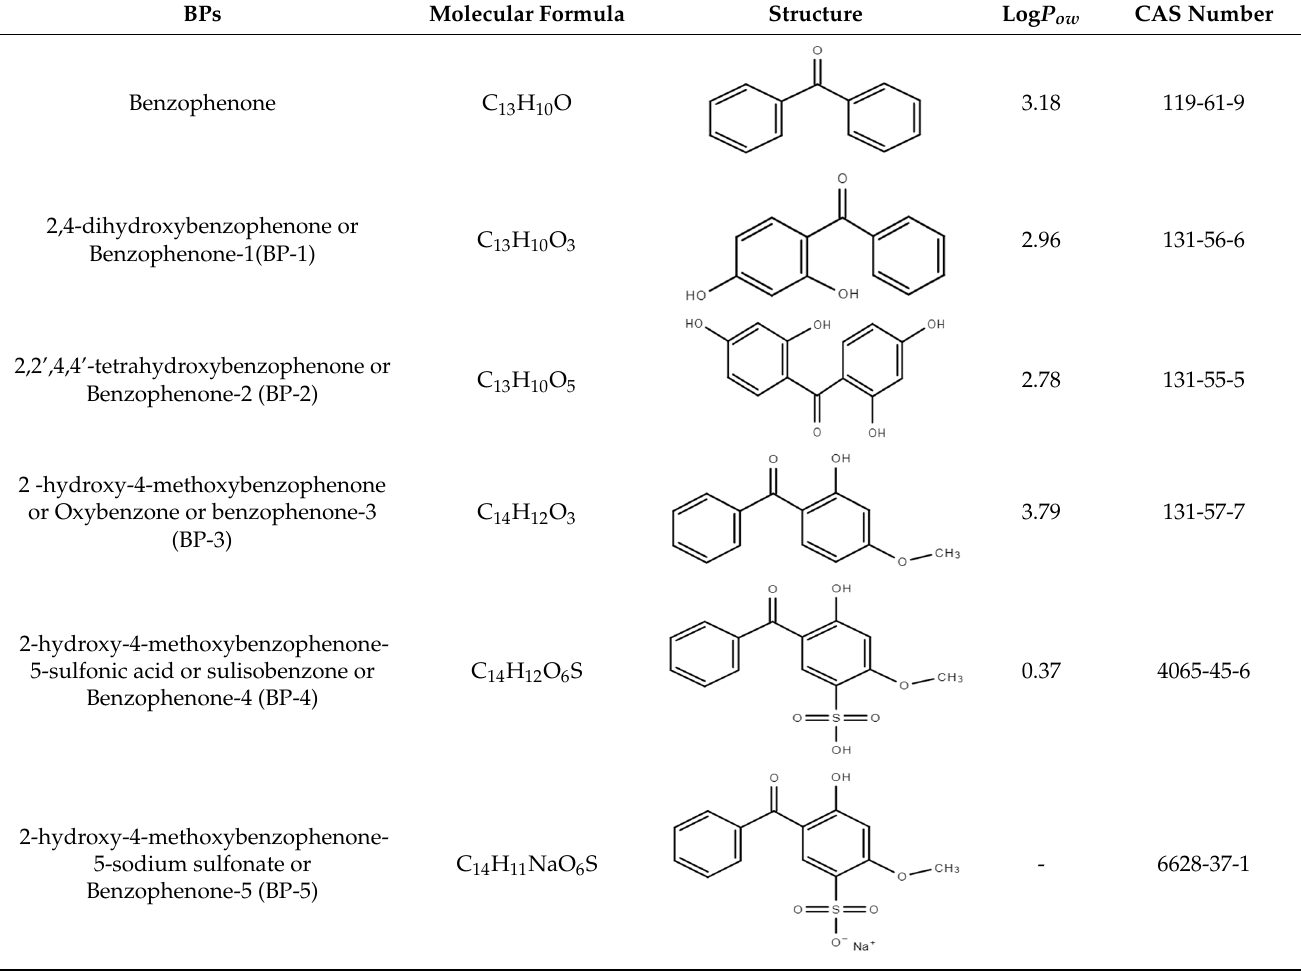
Table 1. Molecular formulas, structures, and octanol/water partition coefficients of BPs (https://pubchem.ncbi.nlm.nih.gov/ accessed on 24 November 2022). Molecular Formula Structure